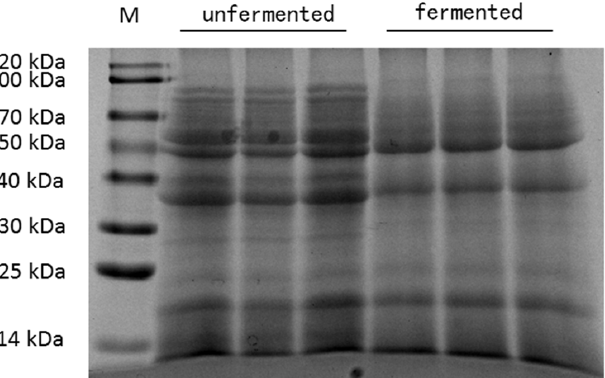
Figure 1. SDS-PAGE map of unfermented mixed feed and fermented mixed feed. M = protein marker.